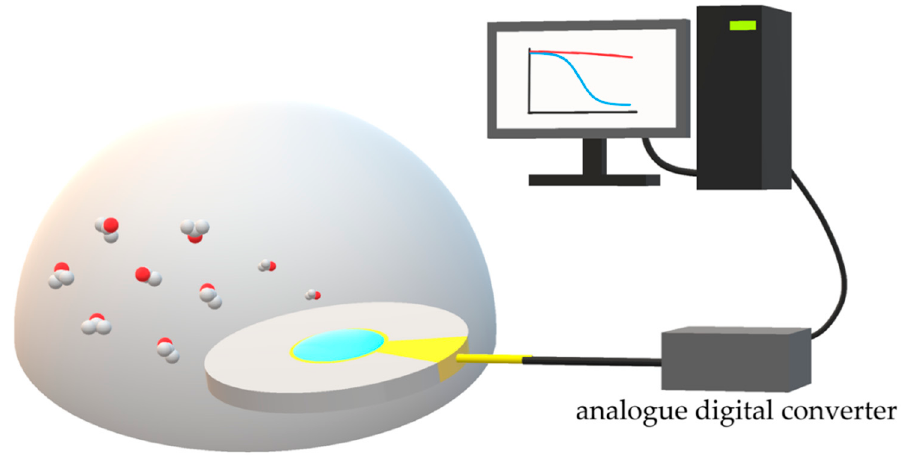
Figure 2. Schematic representation of an AIL-on-QCM gas analysis system.